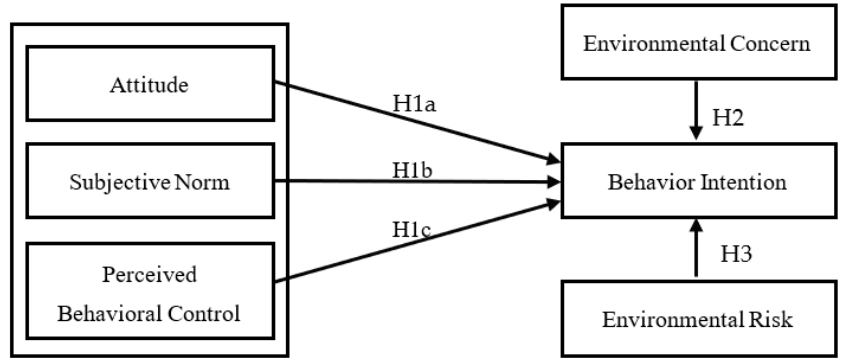
Figure 1. Conceptual model.